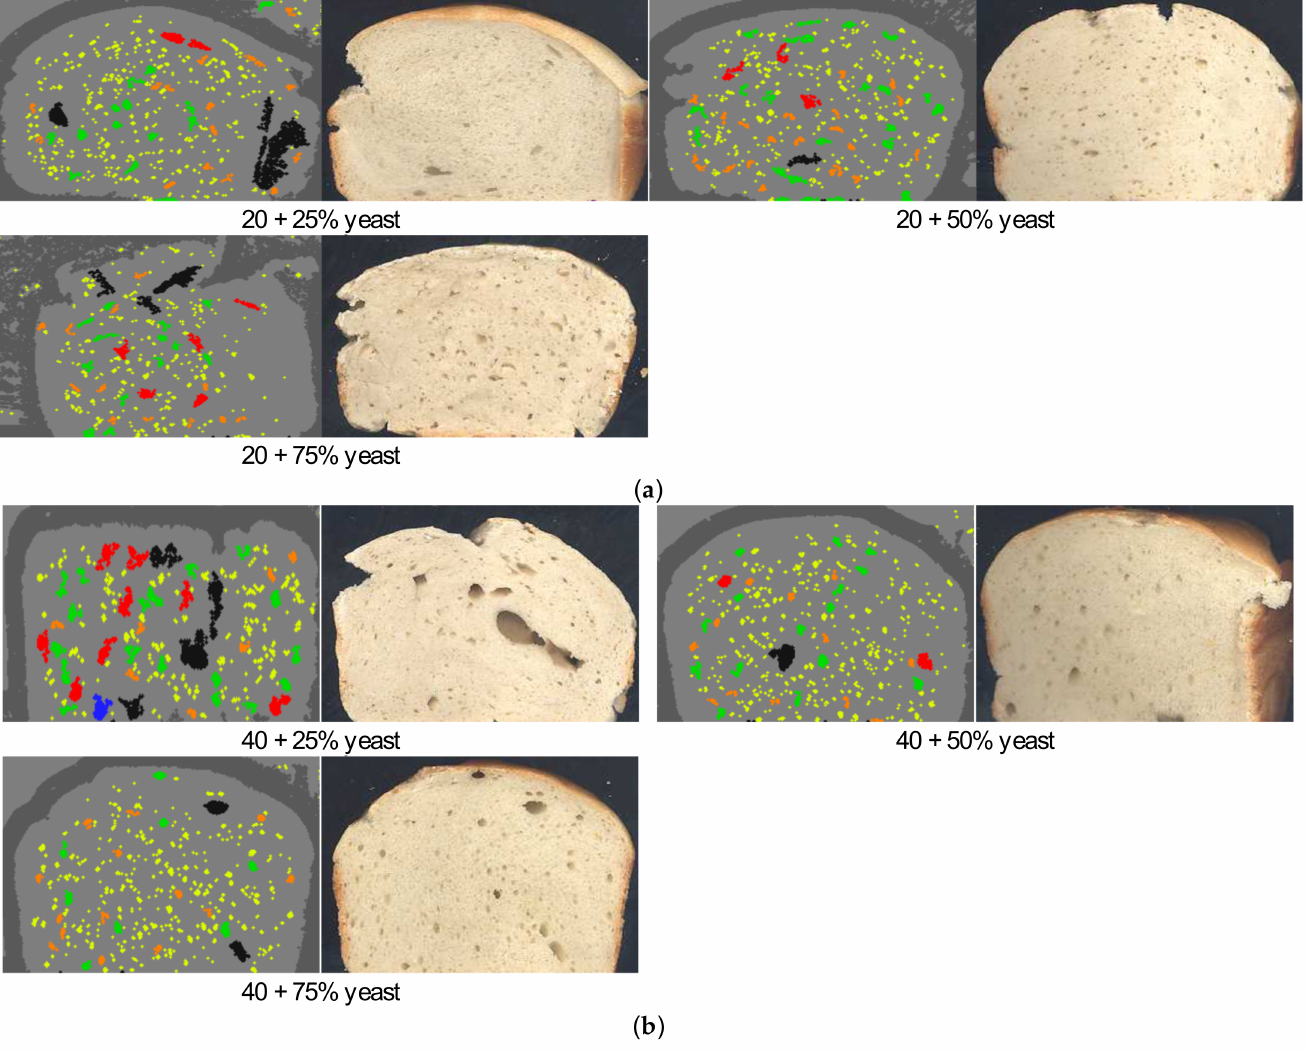
Figure 4. Pore size analysis of ( a ) 20% and ( b ) 40% GH breads with promoters and 25–75% yeast as partial replacement. The figure shows cross-sectional images of the bread pores when they are prepared with different amounts of yeast and